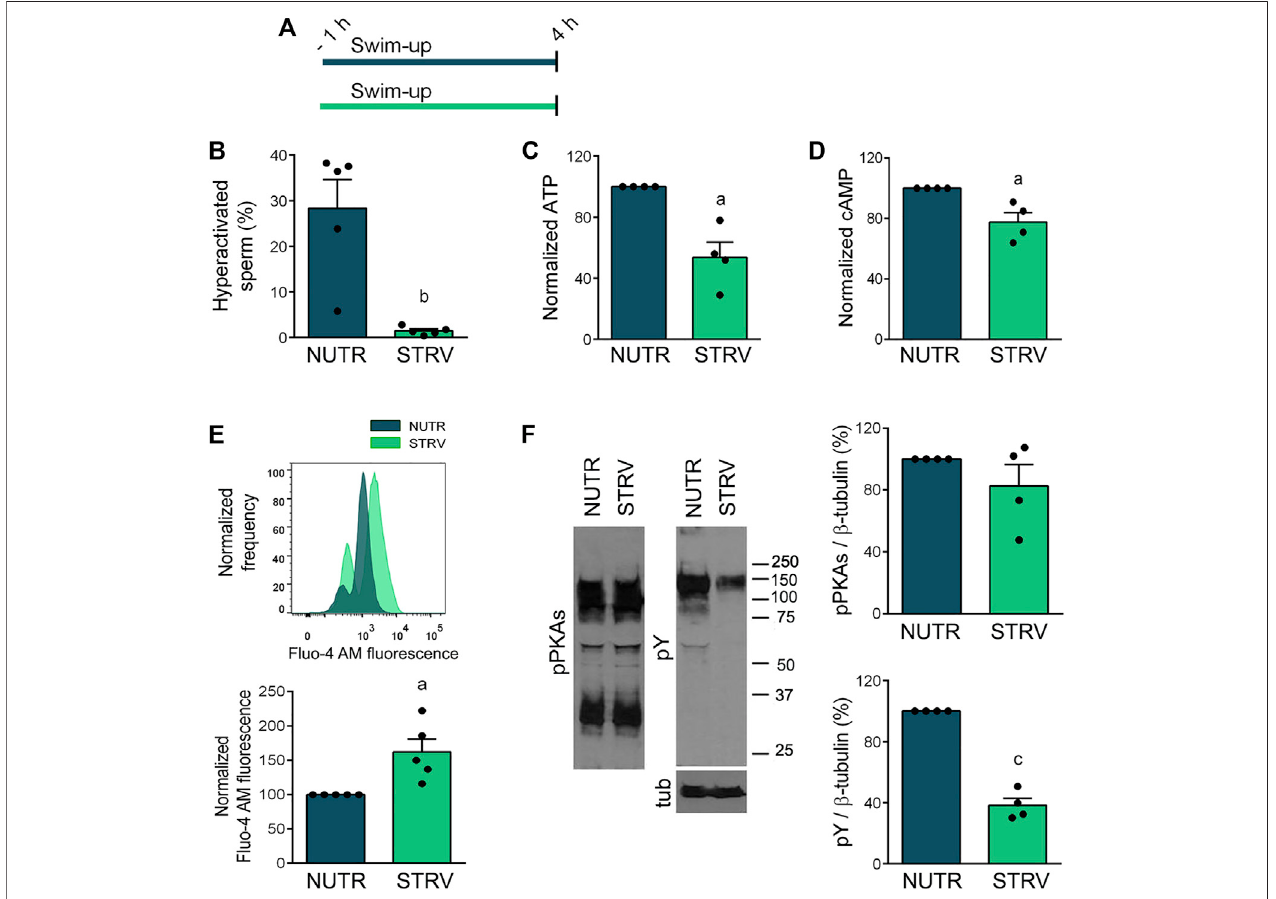
FIGURE 5 | Capacitation-related events in sperm incubated in starving condition. (A) Experimental design. Motile human sperm were selected by swim-up and incubated for 4 h in capacitating conditions in NUTR or STRV media. (B) Hyperactivated sperm. (C) ATP levels normalized against NUTR condition. (D) cAMP levels normalizedagainstNUTRcondition. (E) [Ca 2+ ] i levels.Top:Representativehistogramsofnormalizedfrequencyvs.Fluo-4AM fl uorescenceofnon-PIstainedsperm(live) are shown. Bottom: Normalized Fluo-4 AM fl uorescence compared to NUTR condition. (F) pPKAs and pY levels. Left: Representative Western immunoblotting results are shown. Right: Protein signals were quanti fi ed and expressed as relative to β -tubulin (Tub). Results are expressed as mean ± SEM, n ≥ 4 experiments. a p < 0.05, b p < 0.01, c p < 0.001 vs. NUTR. Student ’ s t test.